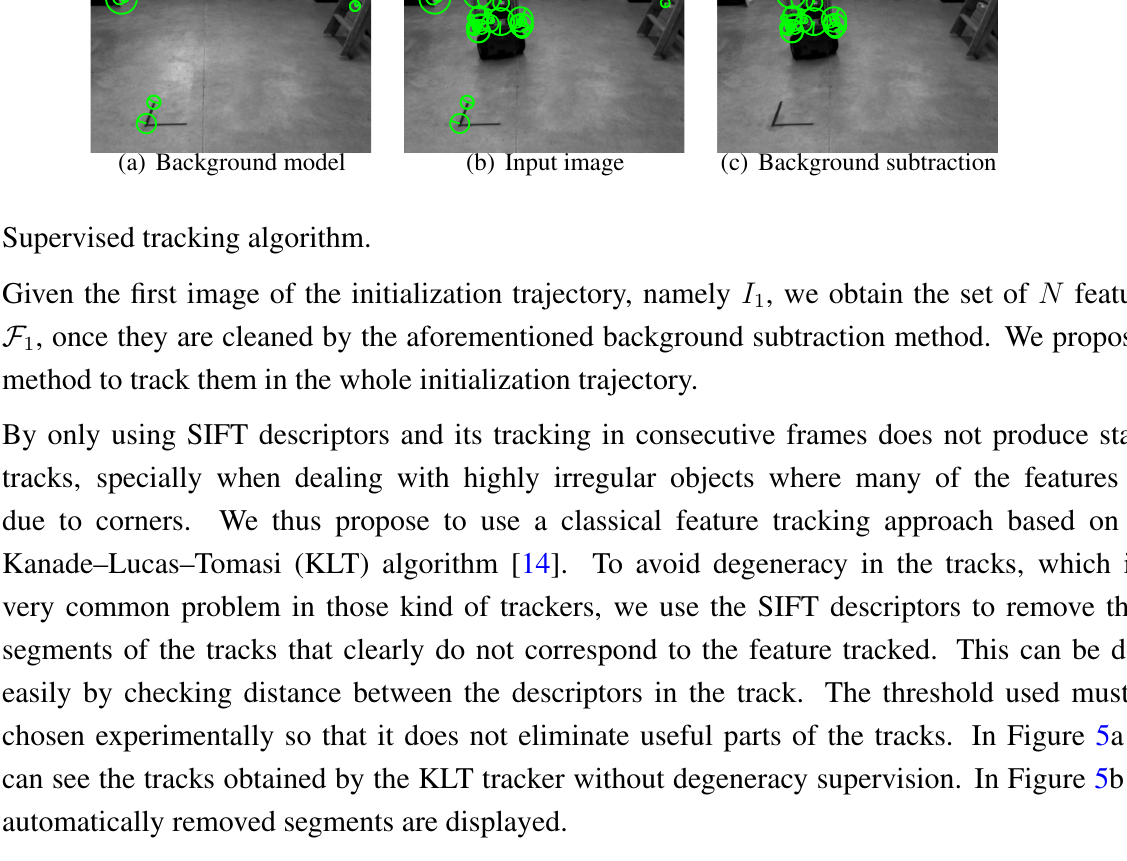
Figure 5. Comparison between the KLT tracker and the SIFT-supervised KLT